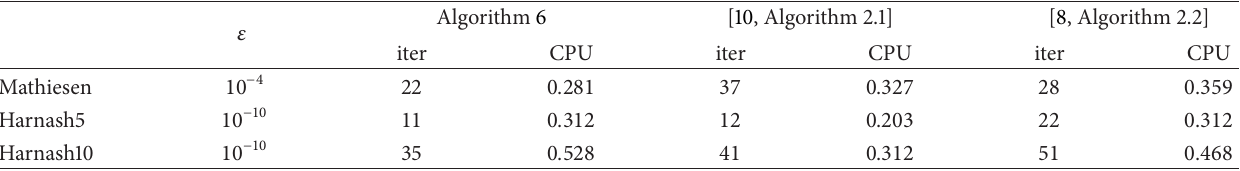
Table 3: Examples 15 and